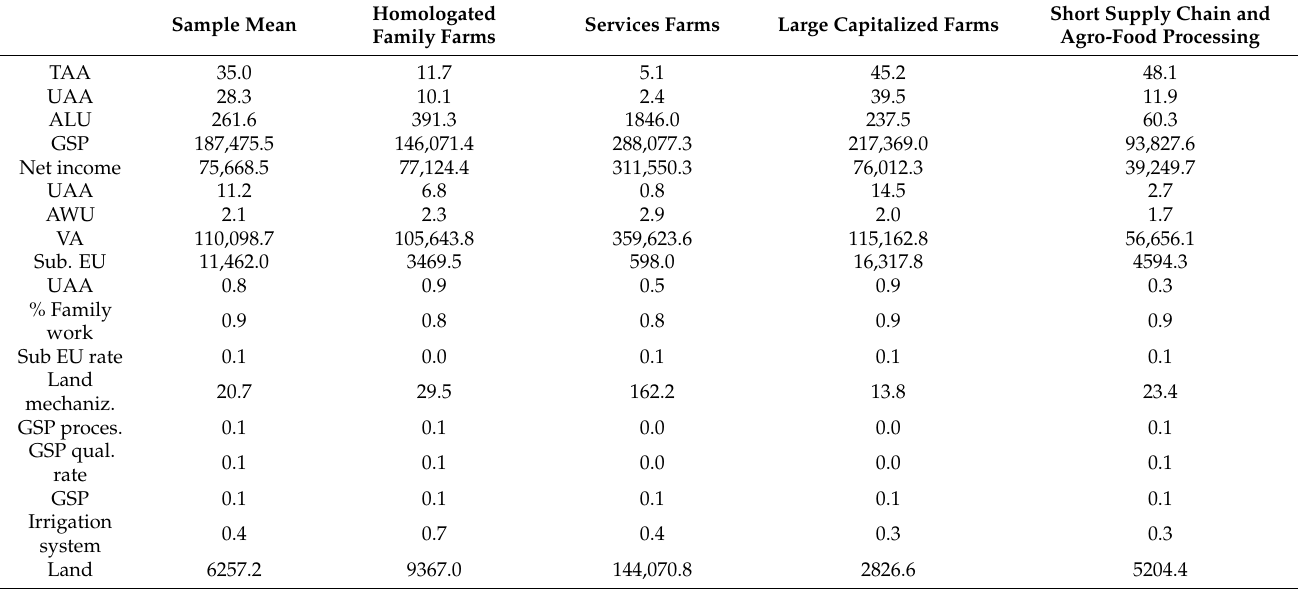
Table A5. Description of the average values of the main structural variables and of the main indexes by cluster identified in the islands geographical breakdown